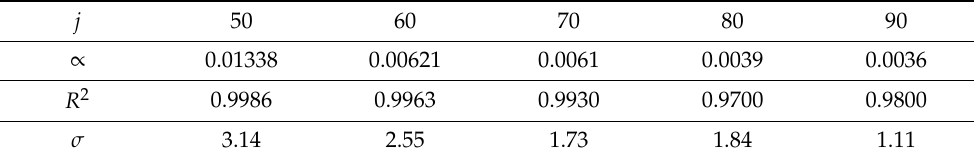
Table 1. For each threshold, ∝ is the coefficient of the second-order term for the non-linear fitting; R squared ( R 2 ) and the standard-deviation ( σ ) are the statistical parameters from the fitting procedure. j